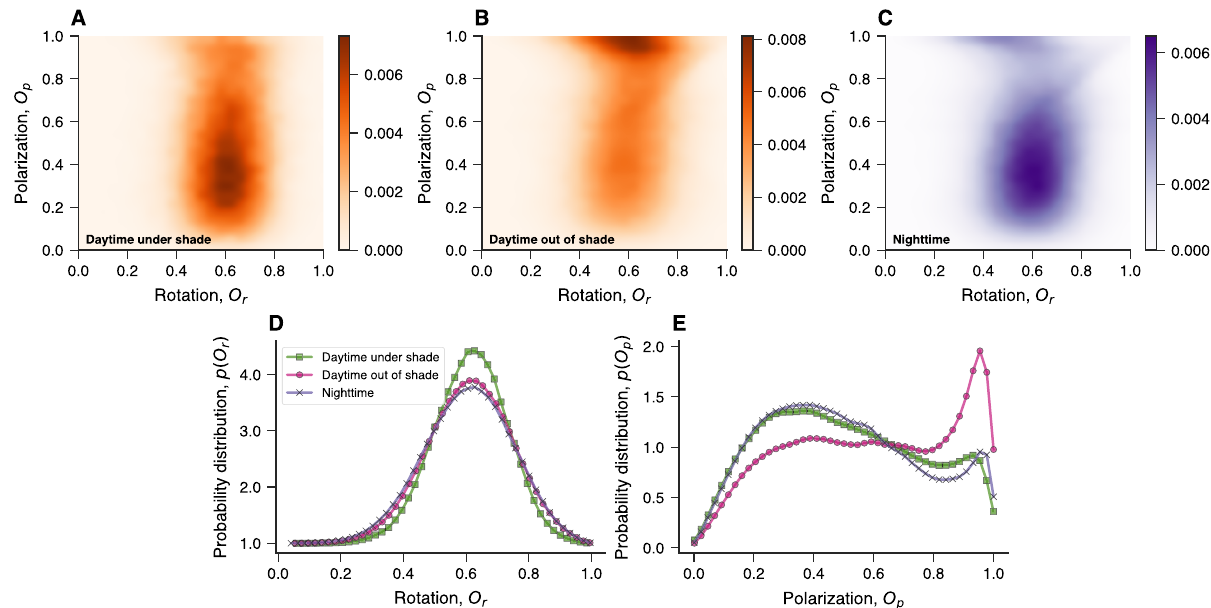
Figure 3. Shade affects schooling behavior of Silver Carp. Joint probability distributions of rotation ( O r ) and polarization ( O p ) order parameters when grouping fish positions into three categories: ( A ) daylight hours under shade, ( B ) daylight hours out of shade, and ( C ) nighttime positions. Marginal distributions of the ( D ) rotation and ( E ) polarization order parameters for the same three categories obtained via kernel density estimation. Apart from the slightly more localized distribution of O r during daylight hours under shade, there is no obvious difference in the degree of collective rotation among the three categories. Conversely, the degree of alignment measured by O p is greater when fish are out of shade during daylight hours than in the other two